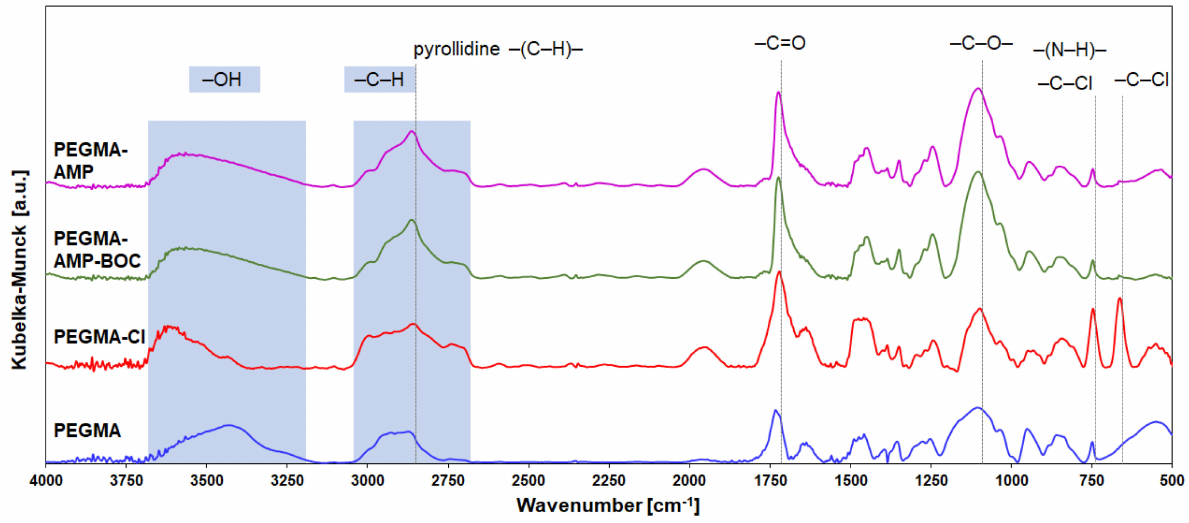
Figure 2. FTIR spectra of (from bottom to top) the PEGMA support, the chlorine-functionalized PEGMA- Cl, the protected amine-functionalized PEGMA-AMP-Boc-3 and the aminated PEGMA-AMP-3. After the polymerization step, a partial substitution of the hydroxyl groups by Cl groups resulted in the partly chlorinated PEGMA material, denoted as PEGMA-Cl (Scheme 1, step 2). In the FTIR spectrum of the PEGMA-Cl material, a strong peak appeared at 660 cm − 1 and the 740 cm − 1 peak intensified, see Figure 2. Both peaks are related to the -C-Cl stretching vibration, confirming the partial substitution of hydroxyl groups by Cl-groups. Effective functionalization with Cl-groups is furthermore supported by the 13 C NMR spectrum (red trace, Figures 3, A6 and A7, Appendix C), by the appearance of the resonance at 44.2 ppm corresponding to the -CH 2 Cl and the decrease in area of the 13 C peak at 62 ppm comprising the resonance of terminal -CH 2 OH groups. From the elemental composition of PEGMA-Cl (see Table 1), it follows that a major fraction of hydroxyl groups (>55%) remains unsubstituted, which serve as promoting groups in the resulting catalyst [13].